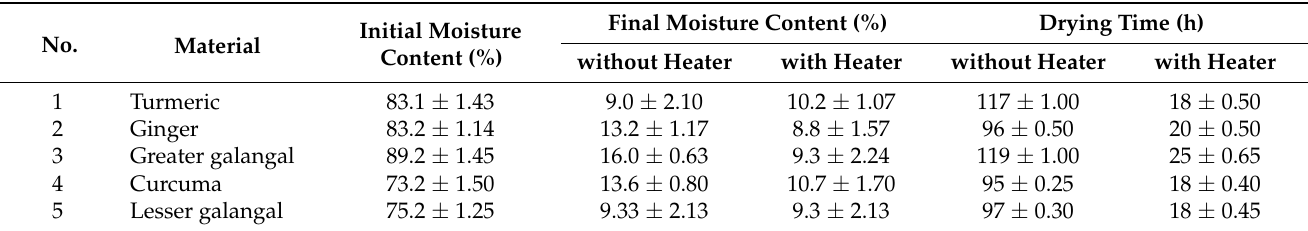
Table 2. Summary of drying time and moisture content in final products of different medicinal plant samples in the Polydryer with and without the operation of a heater.